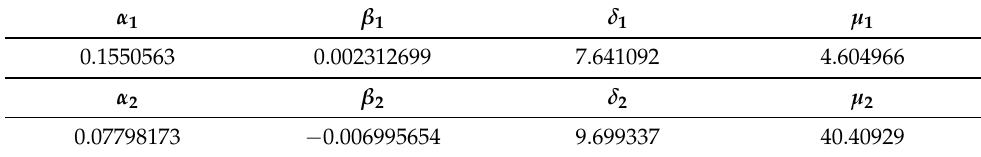
Table 9. Estimation result of the NIG part of RSLDOU model for energy-switching